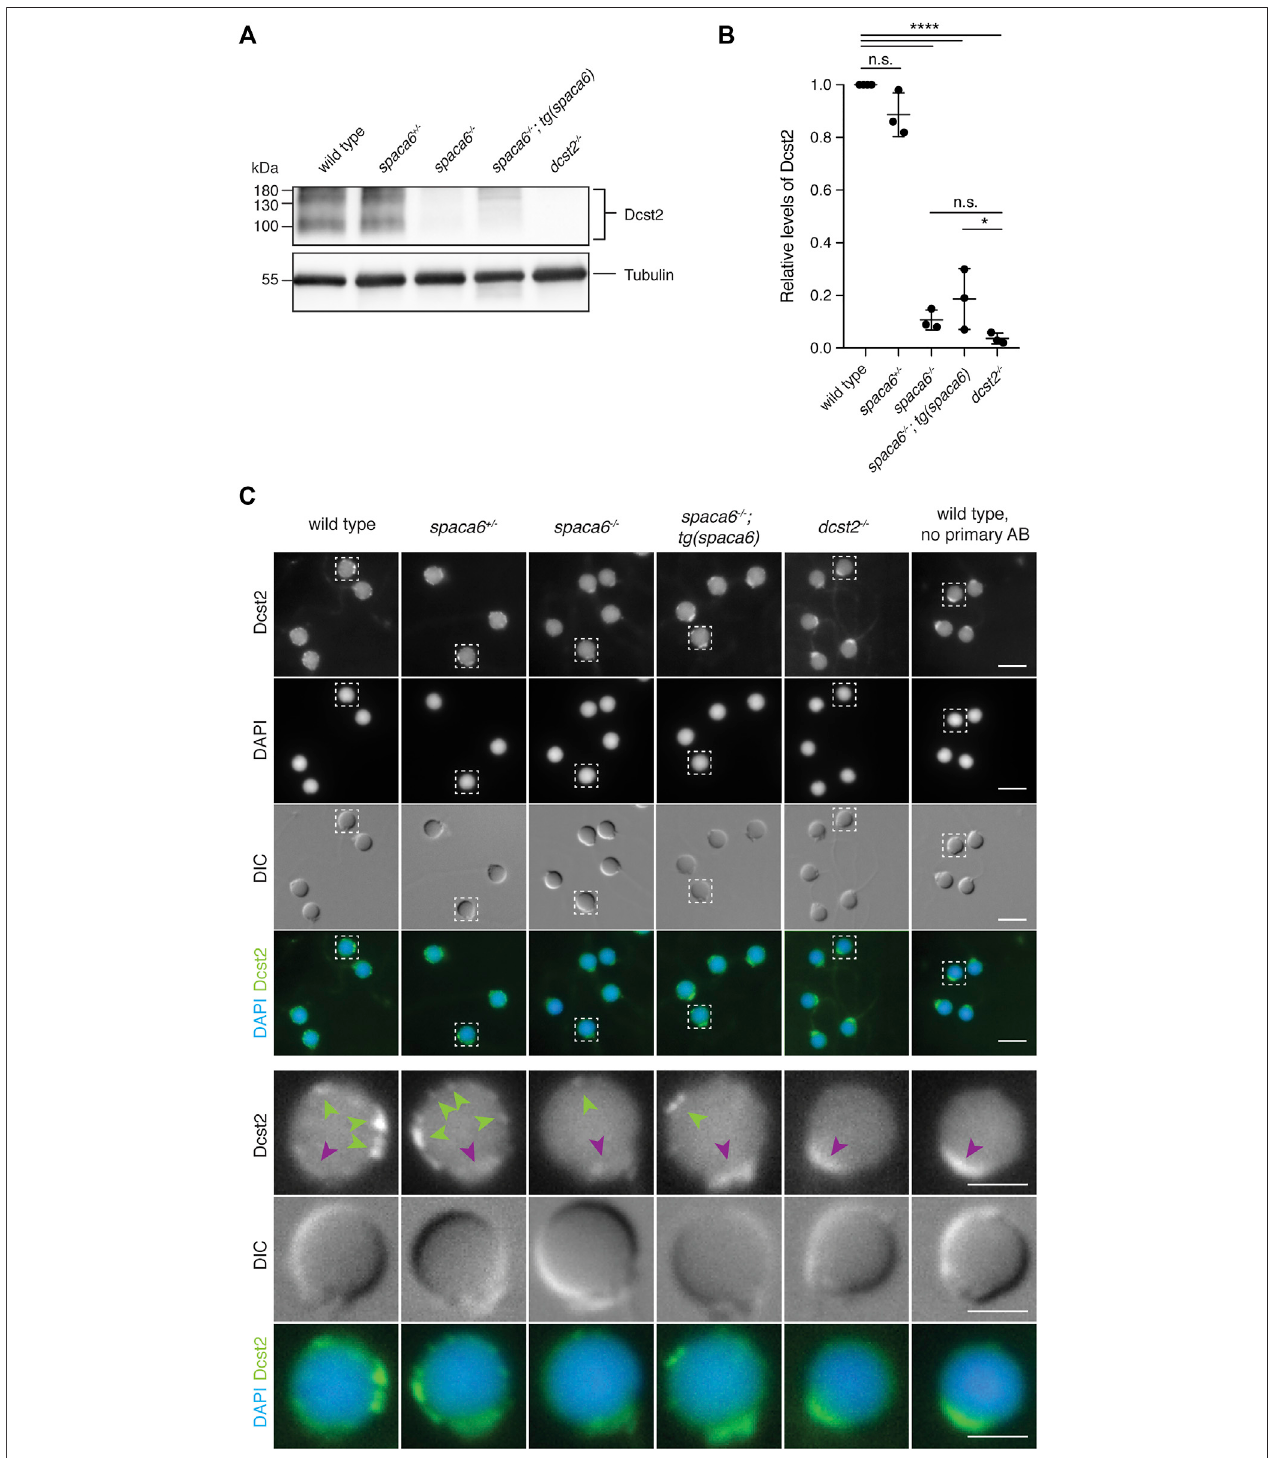
FIGURE 5 | Dcst2 levels are reduced in zebra fi sh spaca6 KO sperm. (A) . Immunoblot of sperm samples of different genotypes probed with antibodies against zebra fi shDcst2.Zebra fi shDcst2ispredictedtobeaglycoprotein,resultinginawiderareaofdetectedsignal.Tubulinproteinlevelsofthesameblotareshownasloading control. The uncropped immunoblot is shown in Supplementary Figure S2 . (B) . Quanti fi cation of sperm Dcst2 levels of different genotypes based on three independent immunoblots. Values were compared to tubulin levels and normalized to wild type. Statistical signi fi cance was calculated using one-way ANOVA and multiple comparisons analysis: n.s, not signi fi cant ( p > 0.05; ****, p < 0.0001; *, p (cid:1) 0.045). (C). Immuno fl uorescent images of Dcst2 protein in sperm heads of different